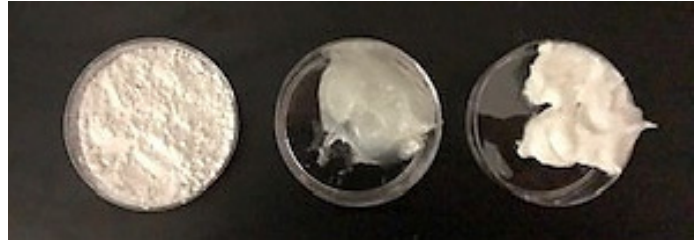
Figure 7. Appearance of BiSCaO (left), ointment (white Vaseline, middle) and 0.2 wt% BiSCaO ointment (right).